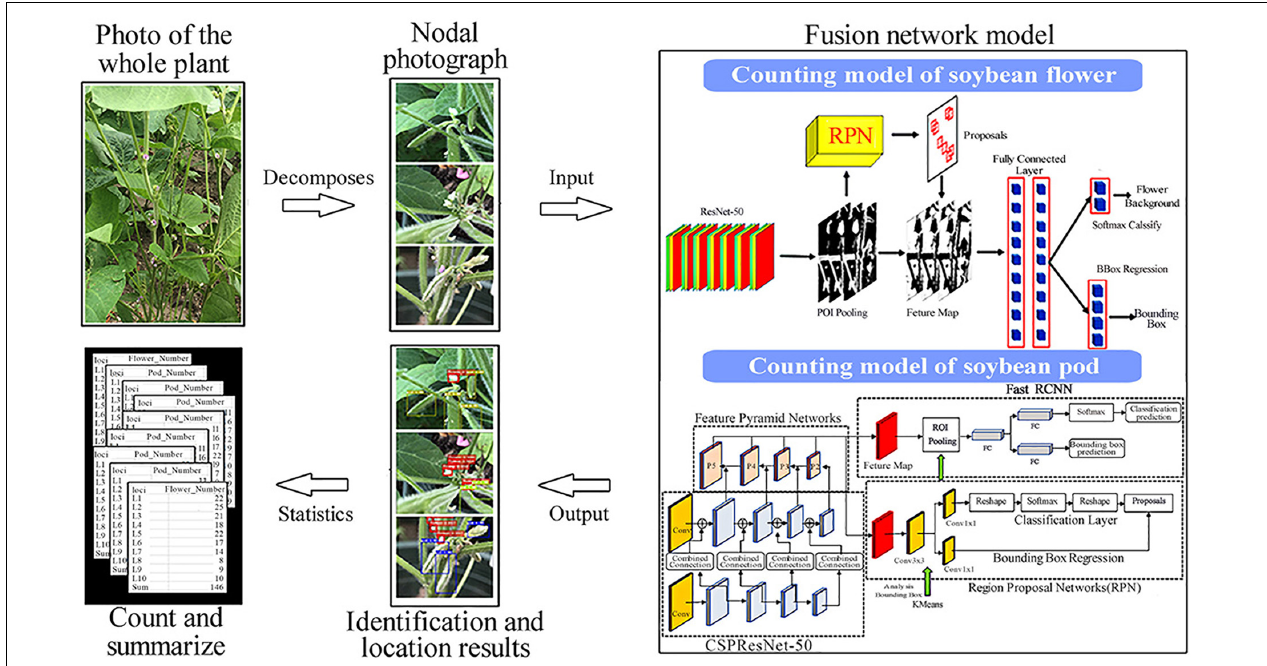
FIGURE 3 | An overall flowchart of the fusion